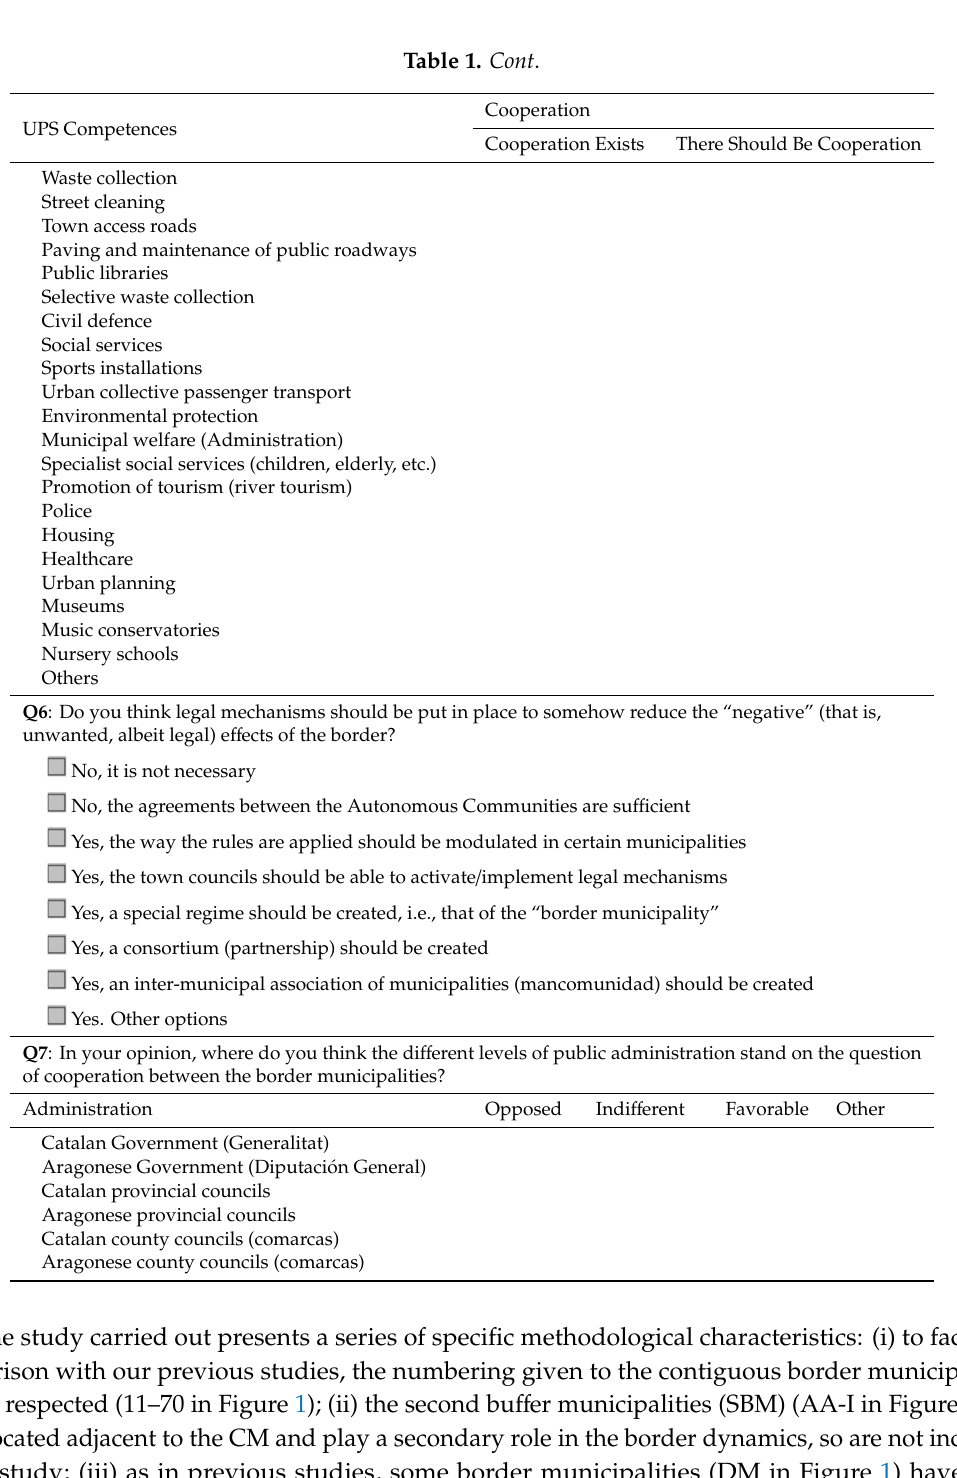
Table 6. Answers obtained in Q4 (source: authors). Q4: Do you think that there should be more cooperation between your municipality and the border municipalities that form part of Catalonia/Aragon? Responses